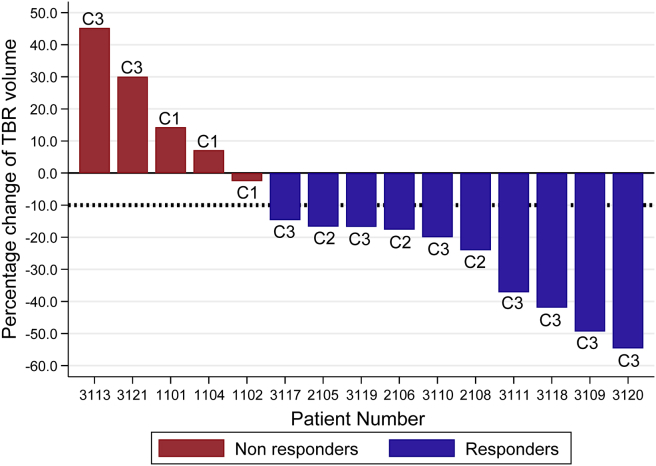
Waterfall plot of change in tumour hypoxic volume. Percentage change of tumour hypoxic volume per patient after 7 days of buparlisib treatment. A ≥10% reduction in hypoxic volume (dotted line) was classified a positive response. C1, cohort 1 (50 mg OD); C2, cohort 2 (80 mg OD); C3, cohort 3 (100 mg OD); FMISO, 18F-fluoromisonidazole; TBR, tumour-to-blood FMISO uptake ratio (≥1.4).